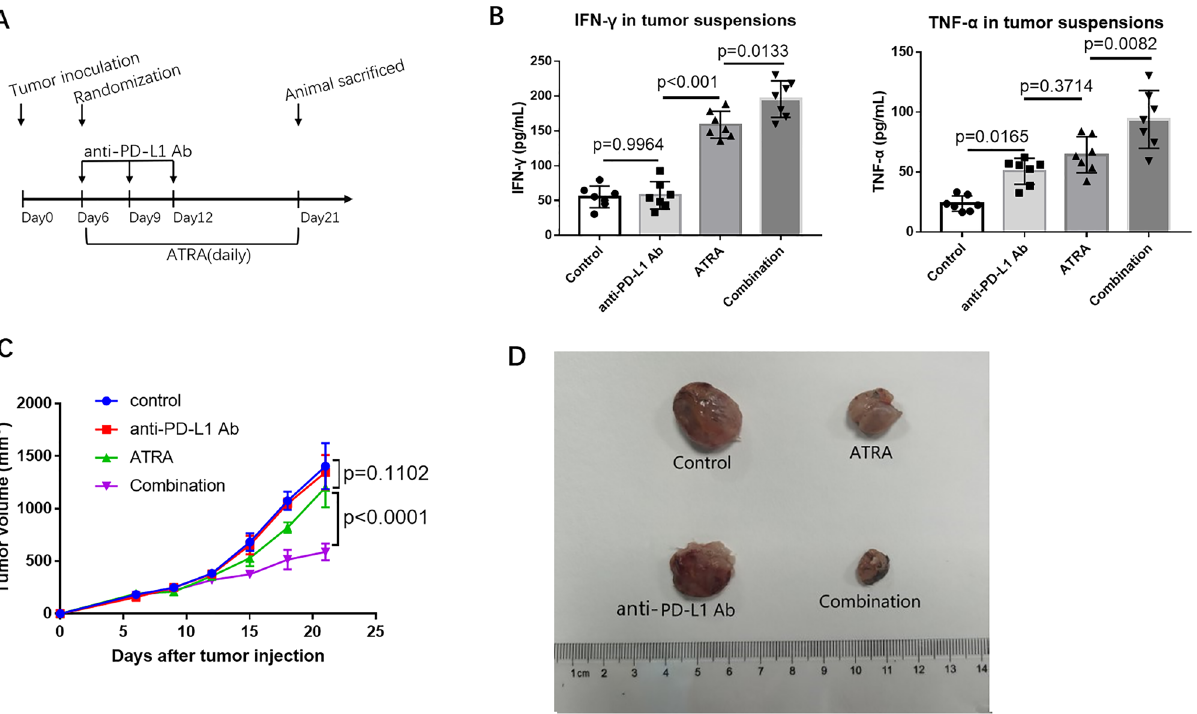
Figure 4. ATRA enhanced the anti-tumor activity of PD-L1 blockade in vivo. ( A ) Experimental design for BALB/c mice, injected with 0.2 mL of U14 cervical cancer cell suspension. From day 6, the mice were injected with ATRA daily, anti-PD-L1 antibody on day 6, 9 and 12, or a combination of both treatments. The mice were sacrificed on day 21. ( B ) Levels of supernatant IFN-γ and TNF-α in different treatment groups were quantified with ELISA (8 mice/group, 2 repetitions with similar results). ( C ) U14 tumor growth curve of BALB/c mice (8 mice/group) with different treatment. Tumor volume was measured and recorded every 3 days after treatment. ( D ) Representative tumor images show the changes in volume between groups on Day 21. Data are shown as mean ±